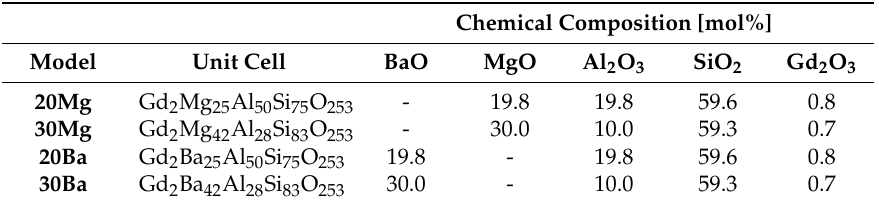
Table 1. Unit cell compositions of the glass structure